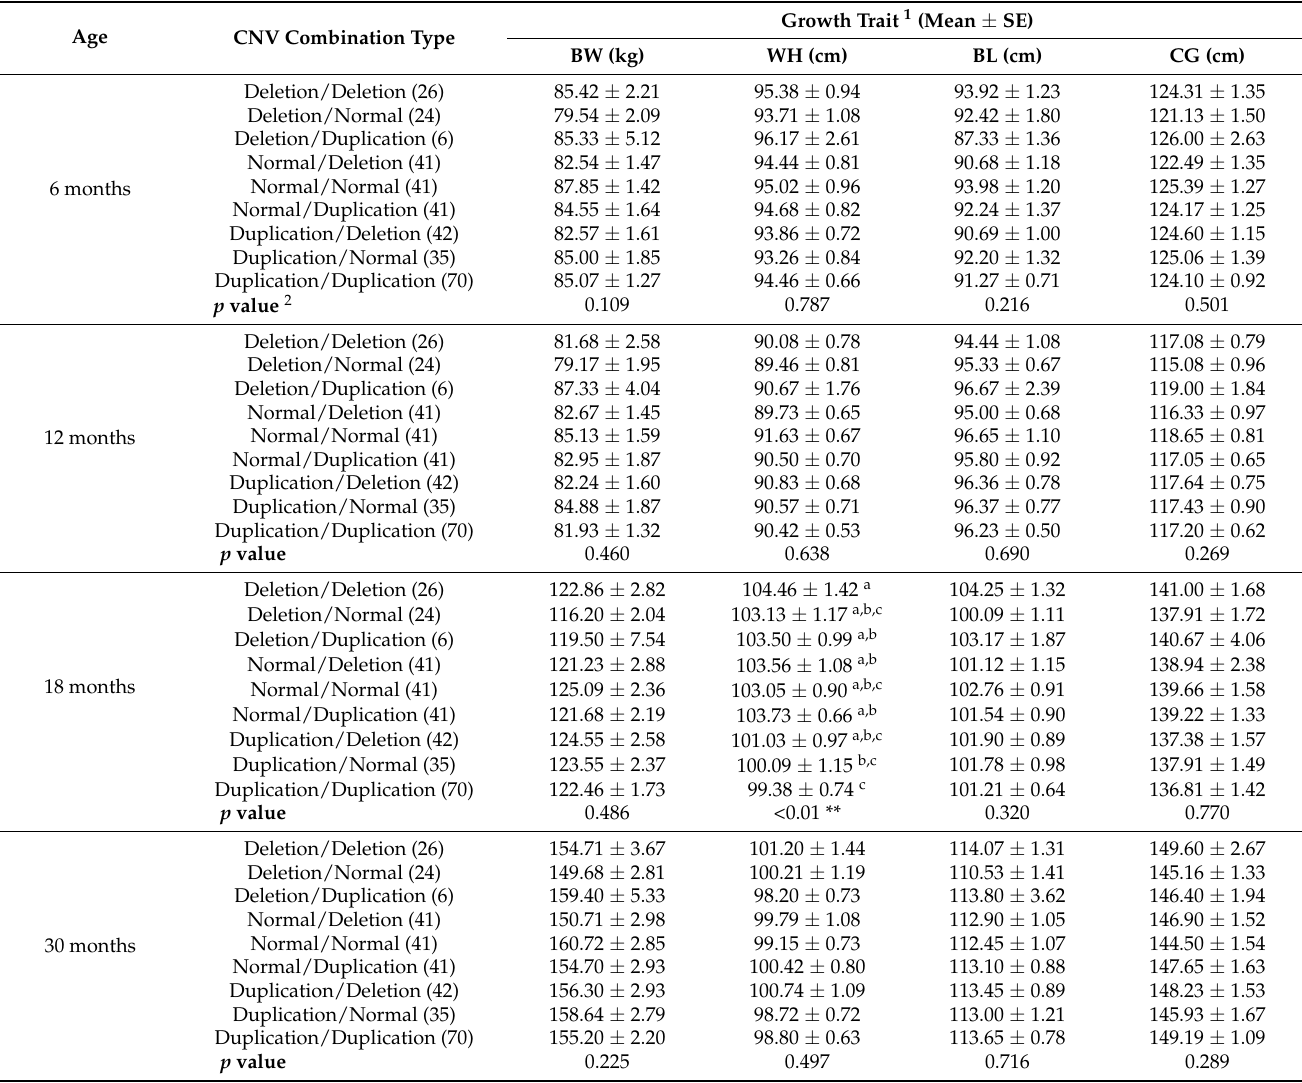
Table 4. Association analysis between CNV combination of SOX5 and SOX8 and growth